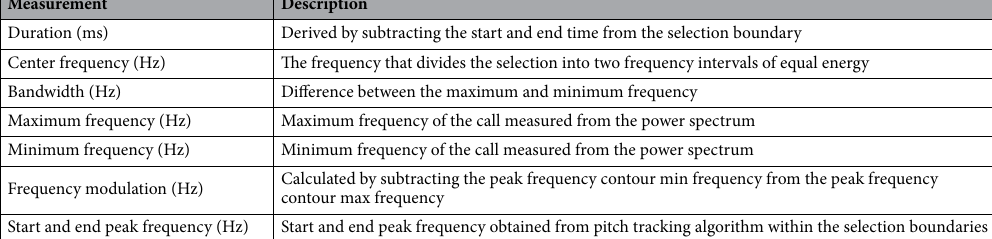
Table 2. Definitions of acoustic descriptors used in analysis of manatee calf vocalizations.